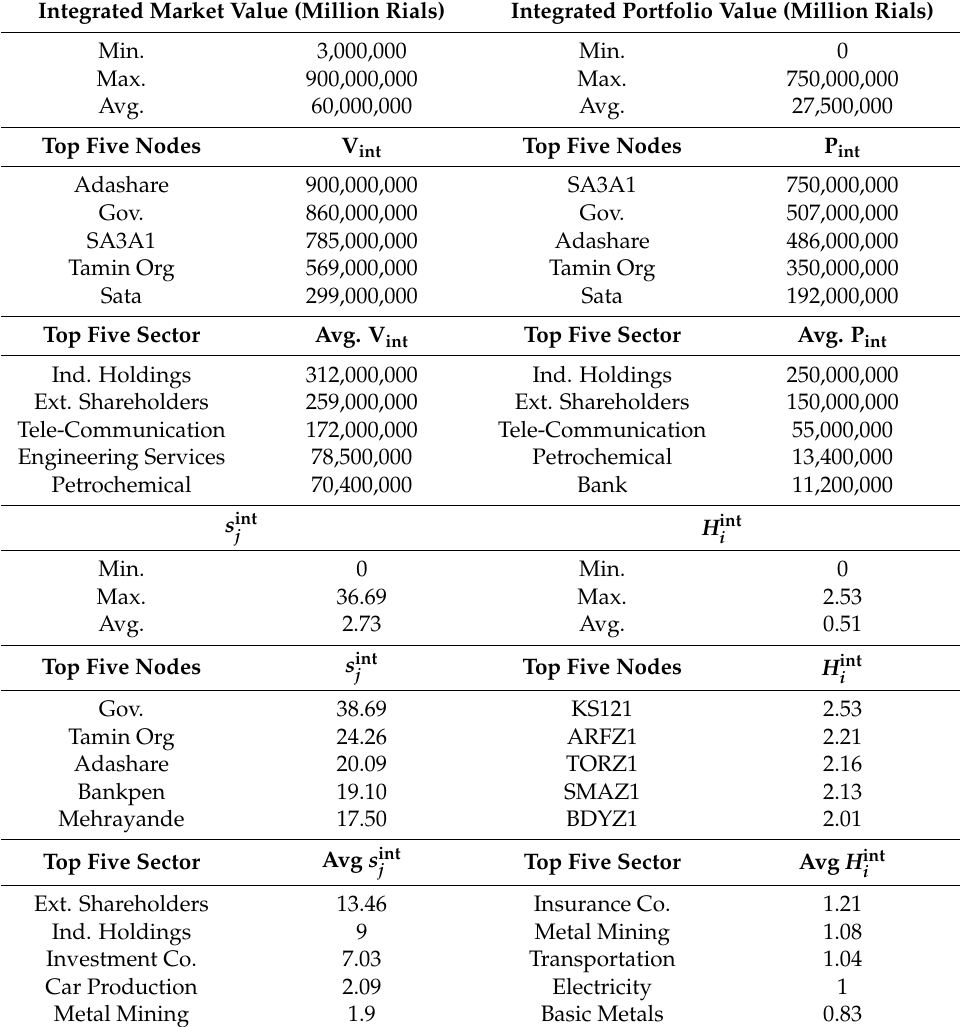
Table 3. Comparison of different systemic risk indices of integrated network in the Tehran Stock